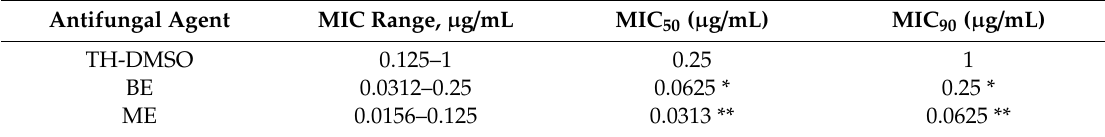
Table 3. In vitro antifungal activity of TH, TH-loaded BE, and ME on C. albicans determined by MIC. Antifungal